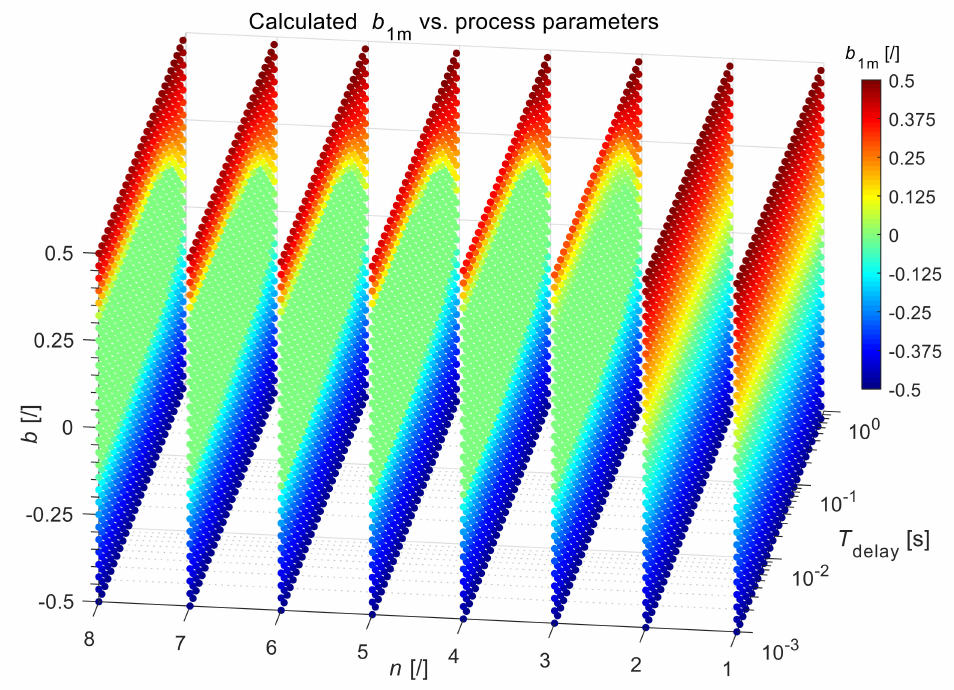
Figure 3. The calculated zeroes b 1m for process G P1 (s) parameters